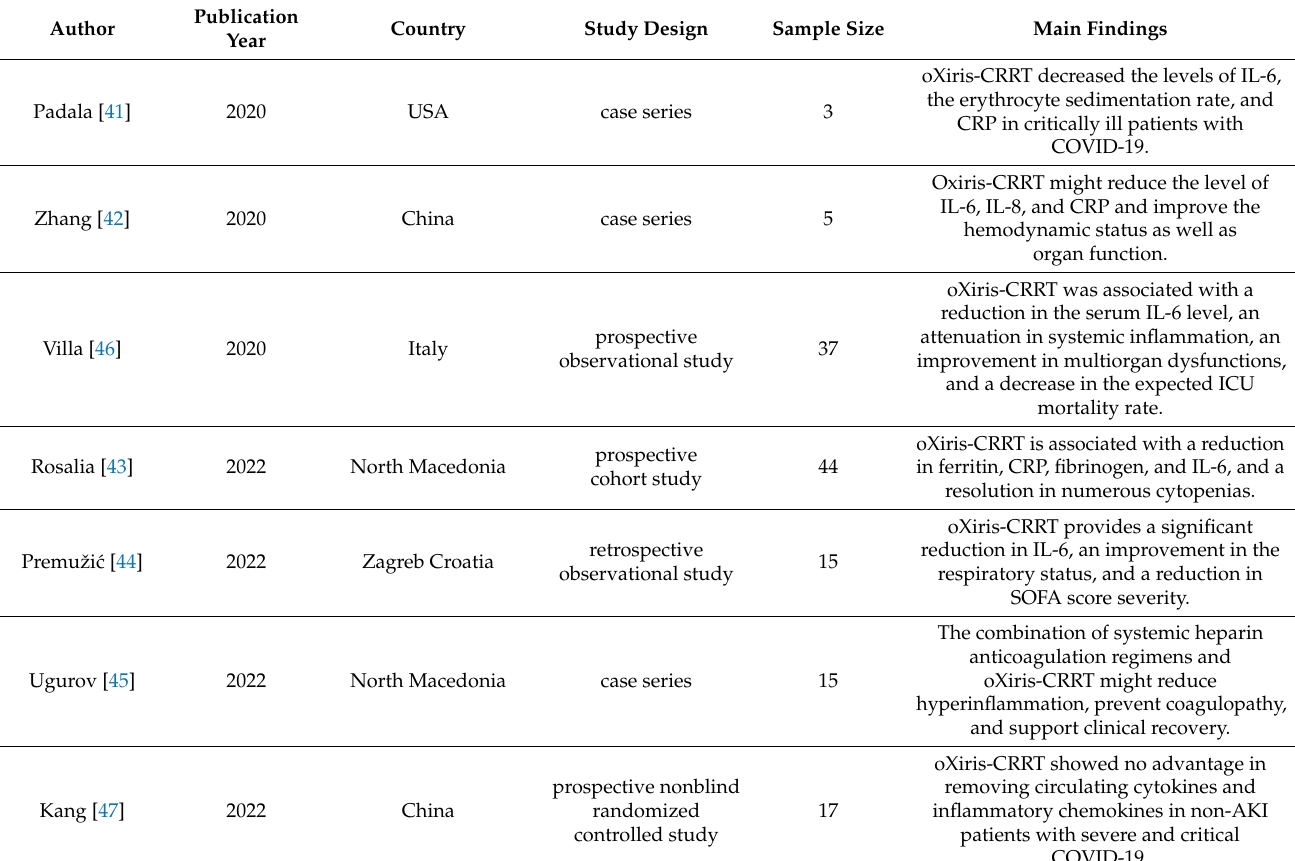
Table 2. Summary of main clinical trials evaluating oXiris-CRRT in COVID-19